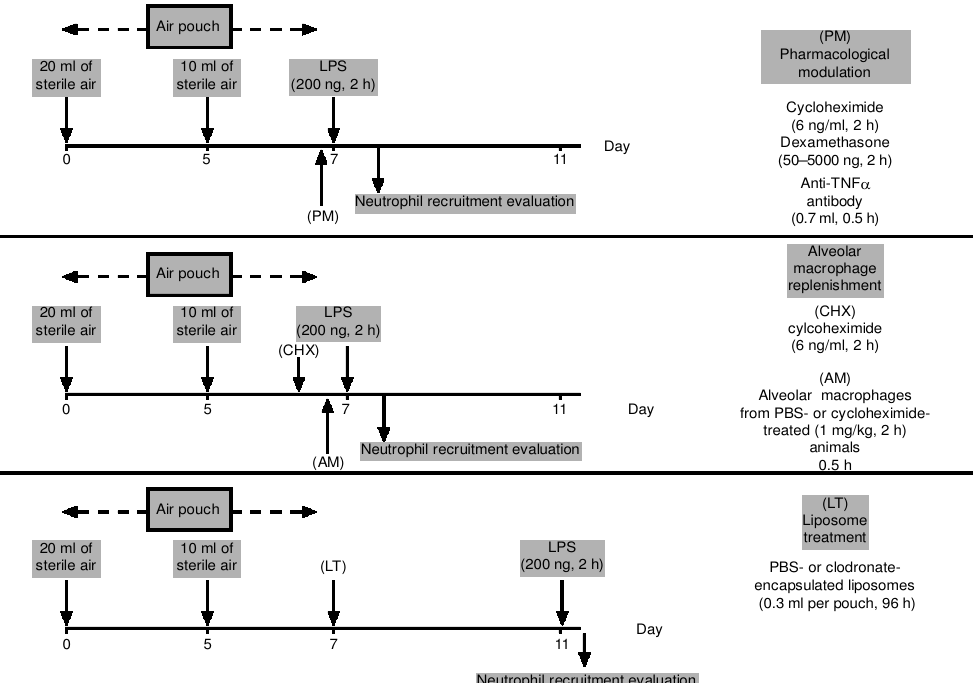
FIG. 9. Flow sheet protocol.